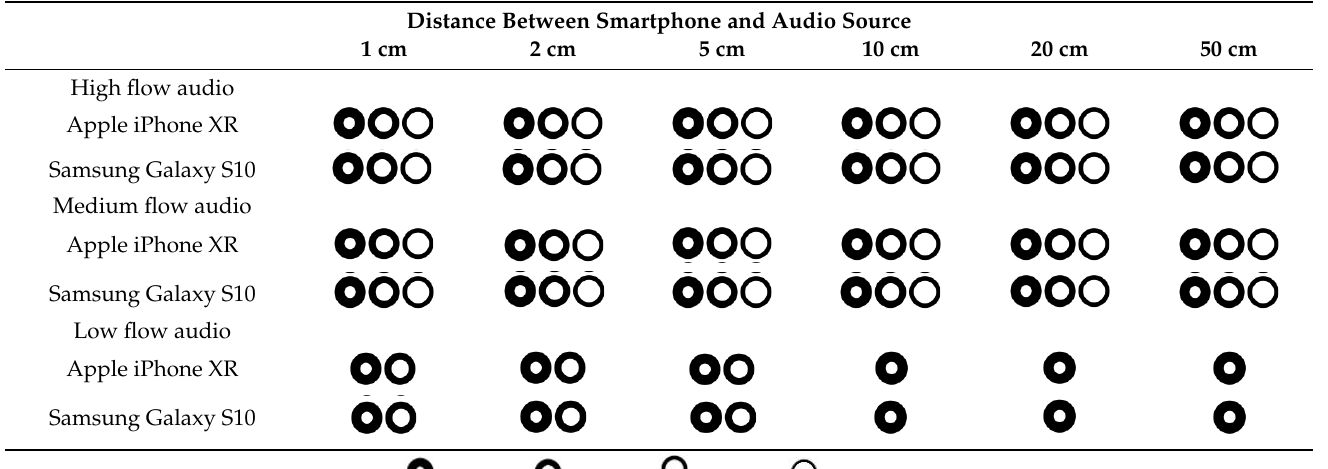
Table 2. QUT Inspire application—range of inspiratory sound detection by flow rate and mouth diameter. When the Table 2. QUT Inspire application — range of inspiratory sound detection by flow rate and mouth diameter. When the fol- Table 2. QUT Inspire application — range of inspiratory sound detection by flow rate and mouth diameter. When the fol- Table 2. QUT Inspire application — range of inspiratory sound detection by flow rate and mouth diameter. When the fol- Table 2. QUT Inspire application — range of inspiratory sound detection by flow rate and mouth diameter. When the fol- Table 2. QUT Inspire application — range of inspiratory sound detection by flow rate and mouth diameter. When the fol- Table 2. QUT Inspire application — range of inspiratory sound detection by flow rate and mouth diameter. When the fol- Table 2. QUT Inspire application — range of inspiratory sound detection by flow rate and mouth diameter. When the fol- Table 2. QUT Inspire application — range of inspiratory sound detection by flow rate and mouth diameter. When the fol- Table 2. QUT Inspire application — range of inspiratory sound detection by flow rate and mouth diameter. When the fol- Table 2. QUT Inspire application — range of inspiratory sound detection by flow rate and mouth diameter. When the fol- Table 2. QUT Inspire application — range of inspiratory sound detection by flow rate and mouth diameter. When the fol- Table 2. QUT Inspire application — range of inspiratory sound detection by flow rate and mouth diameter. When the fol- Table 2. QUT Inspire application — range of inspiratory sound detection by flow rate and mouth diameter. When the fol- Table 2. QUT Inspire application — range of inspiratory sound detection by flow rate and mouth diameter. When the fol- Table 2. QUT Inspire application — range of inspiratory sound detection by flow rate and mouth diameter. When the fol- Table 2. QUT Inspire application — range of inspiratory sound detection by flow rate and mouth diameter. When the fol- Table 2. QUT Inspire application — range of inspiratory sound detection by flow rate and mouth diameter. When the fol- Table 2. QUT Inspire application — range of inspiratory sound detection by flow rate and mouth diameter. When the fol- following symbols are shown it means sound was detected using the corresponding simulated mouth diameter. lowing symbols are shown it means sound was detected using the corresponding simulated mouth diameter:. lowing symbols are shown it means sound was detected using the corresponding simulated mouth diameter:. lowing symbols are shown it means sound was detected using the corresponding simulated mouth diameter:. lowing symbols are shown it means sound was detected using the corresponding simulated mouth diameter:. lowing symbols are shown it means sound was detected using the corresponding simulated mouth diameter:. lowing symbols are shown it means sound was detected using the corresponding simulated mouth diameter:. Table 2. QUT Inspire application — range of inspiratory sound detection by flow rate and mouth diameter. When the fol- Table 2. QUT Inspire application — range of inspiratory sound detection by flow rate and mouth diameter. When the fol- Table 2. QUT Inspire application — range of inspiratory sound detection by flow rate and mouth diameter. When the fol- Table 2. QUT Inspire application — range of inspiratory sound detection by flow rate and mouth diameter. When the fol- Table 2. QUT Inspire application — range of inspiratory sound detection by flow rate and mouth diameter. When the fol- Table 2. QUT Inspire application — range of inspiratory sound detection by flow rate and mouth diameter. When the fol- Table 2. QUT Inspire application — range of inspiratory sound detection by flow rate and mouth diameter. When the fol- Table 2. QUT Inspire application — range of inspiratory sound detection by flow rate and mouth diameter. When the fol- Table 2. QUT Inspire application — range of inspiratory sound detection by flow rate and mouth diameter. When the fol- Table 2. QUT Inspire application — range of inspiratory sound detection by flow rate and mouth diameter. When the fol- Table 2. QUT Inspire application — range of inspiratory sound detection by flow rate and mouth diameter. When the fol- lowing symbols are shown it means sound was detected using the corresponding simulated mouth diameter:. Table 2. QUT Inspire application — range of inspiratory sound detection by flow rate and mouth diameter. When the fol- lowing symbols are shown it means sound was detected using the corresponding simulated mouth diameter:. lowing symbols are shown it means sound was detected using the corresponding simulated mouth diameter:. lowing symbols are shown it means sound was detected using the corresponding simulated mouth diameter:. lowing symbols are shown it means sound was detected using the corresponding simulated mouth diameter:. lowing symbols are shown it means sound was detected using the corresponding simulated mouth diameter:. lowing symbols are shown it means sound was detected using the corresponding simulated mouth diameter:. lowing symbols are shown it means sound was detected using the corresponding simulated mouth diameter:. lowing symbols are shown it means sound was detected using the corresponding simulated mouth diameter:. lowing symbols are shown it means sound was detected using the corresponding simulated mouth diameter:. lowing symbols are shown it means sound was detected using the corresponding simulated mouth diameter:. Table 2. QUT Inspire application — range of inspiratory sound detection by flow rate and mouth diameter. When the fol- lowing symbols are shown it means sound was detected using the corresponding simulated mouth diameter:. Table 2. QUT Inspire application — range of inspiratory sound detection by flow rate and mouth diameter. When the fol- Table 2. QUT Inspire application — range of inspiratory sound detection by flow rate and mouth diameter. When the fol- Table 2. QUT Inspire application — range of inspiratory sound detection by flow rate and mouth diameter. When the fol- Table 2. QUT Inspire application — range of inspiratory sound detection by flow rate and mouth diameter. When the fol- Table 2. QUT Inspire application — range of inspiratory sound detection by flow rate and mouth diameter. When the fol- lowing symbols are shown it means sound was detected using the corresponding simulated mouth diameter:. lowing symbols are shown it means sound was detected using the corresponding simulated mouth diameter:. lowing symbols are shown it means sound was detected using the corresponding simulated mouth diameter:. lowing symbols are shown it means sound was detected using the corresponding simulated mouth diameter:. lowing symbols are shown it means sound was detected using the corresponding simulated mouth diameter:. lowing symbols are shown it means sound was detected using the corresponding simulated mouth diameter:. Table 2. QUT Inspire application — range of inspiratory sound detection by flow rate and mouth diameter. When the fol- Table 2. QUT Inspire application — range of inspiratory sound detection by flow rate and mouth diameter. When the fol- Table 2. QUT Inspire application — range of inspiratory sound detection by flow rate and mouth diameter. When the fol- Table 2. QUT Inspire application — range of inspiratory sound detection by flow rate and mouth diameter. When the fol- lowing symbols are shown it means sound was detected using the corresponding simulated mouth diameter:. lowing symbols are shown it means sound was detected using the corresponding simulated mouth diameter:. lowing symbols are shown it means sound was detected using the corresponding simulated mouth diameter:. lowing symbols are shown it means sound was detected using the corresponding simulated mouth diameter:. lowing symbols are shown it means sound was detected using the corresponding simulated mouth diameter:. lowing symbols are shown it means sound was detected using the corresponding simulated mouth diameter:. lowing symbols are shown it means sound was detected using the corresponding simulated mouth diameter:. lowing symbols are shown it means sound was detected using the corresponding simulated mouth diameter:. lowing symbols are shown it means sound was detected using the corresponding simulated mouth diameter:. lowing symbols are shown it means sound was detected using the corresponding simulated mouth diameter:. lowing symbols are shown it means sound was detected using the corresponding simulated mouth diameter:. lowing symbols are shown it means sound was detected using the corresponding simulated mouth diameter:. lowing symbols are shown it means sound was detected using the corresponding simulated mouth diameter:. lowing symbols are shown it means sound was detected using the corresponding simulated mouth diameter:. lowing symbols are shown it means sound was detected using the corresponding simulated mouth diameter:. lowing symbols are shown it means sound was detected using the corresponding simulated mouth